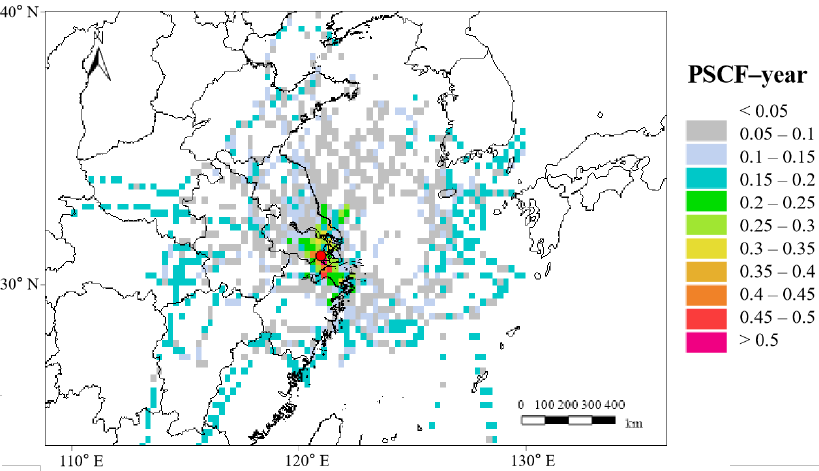
Figure 8. PSCF analysis result at Shanghai during the sampling period in 2019. Data from the PD site were selected for analysis.